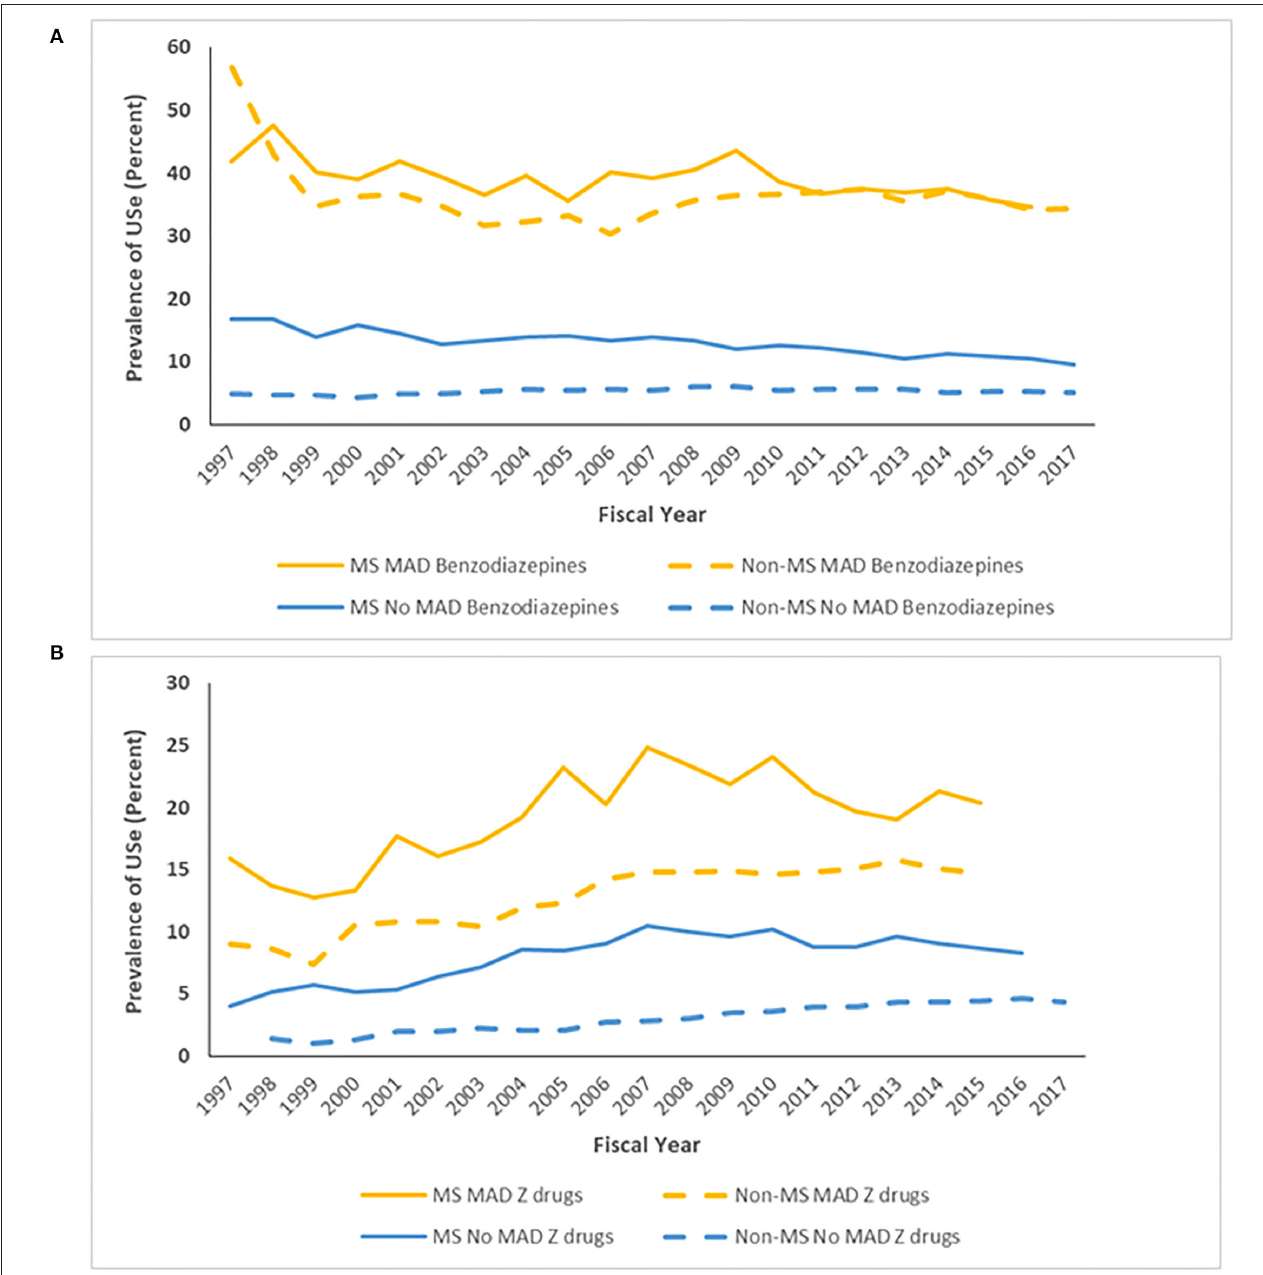
FIGURE 4 | Age- and sex-standardized* prevalence of (A) benzodiazepine and (B) Z-drug use stratified by cohort and mood/anxiety disorder. *To 2010 Canadian population.